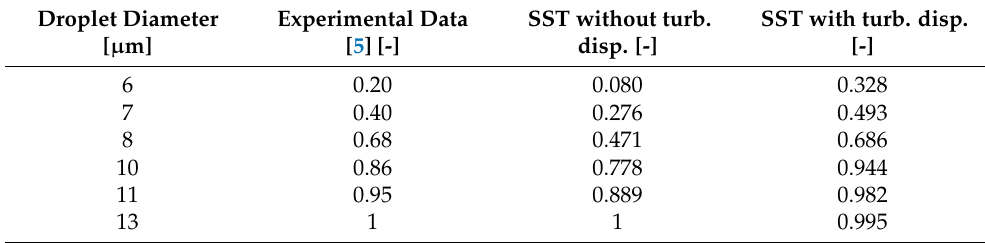
Table 8. Comparison of calculated results obtained with SST model with and without using turbulent dispersion with experimental data for geometry B_10_0 with inlet velocity 4 m s − 1 .